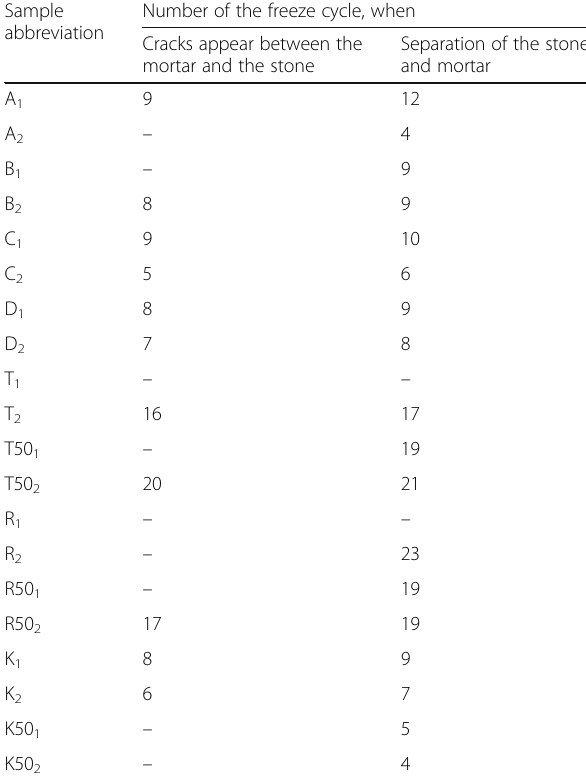
Table 3 Failure of the tested mortar/stone sample formation of cracks and separation of stone/mortar interface (number of freeze-thaw cycles are